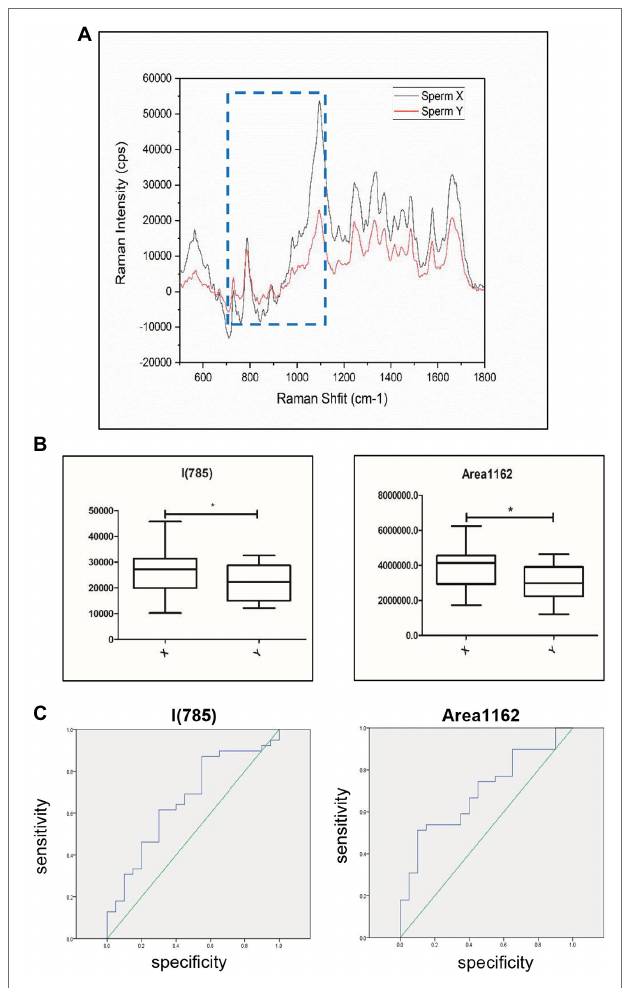
FIGURE 5 | Discrimination of sperm with different DNA contents by Raman spectroscopy. (A) Raman spectra of the 500–1800 cm − 1 area corresponding to X sperm and Y sperm. Black shows Y sperm and red shows X sperm. Raman peaks with the most significant difference for this study are highlighted by blue dotted lines. The x-axis units are displacement wavenumber (cm − 1 ), nanometer (nm). and absolute wavenumber (cm − 1 ). The y-axis unit is generally Raman strength. (B) The peak values of X and Y sperm in Area714-1,162 and I785. X, X sperm; Y, Y sperm. [ n (X) = 39, n (Y) = 20, *, p < 0.05]. (C) Raman analysis data characteristics curve for sperm sex chromosomes. The area under the ROC curve indicates the prediction capacity of the model. Raman analysis data in I785 (AUC¼0.662). Raman analysis data in Area714-1,162